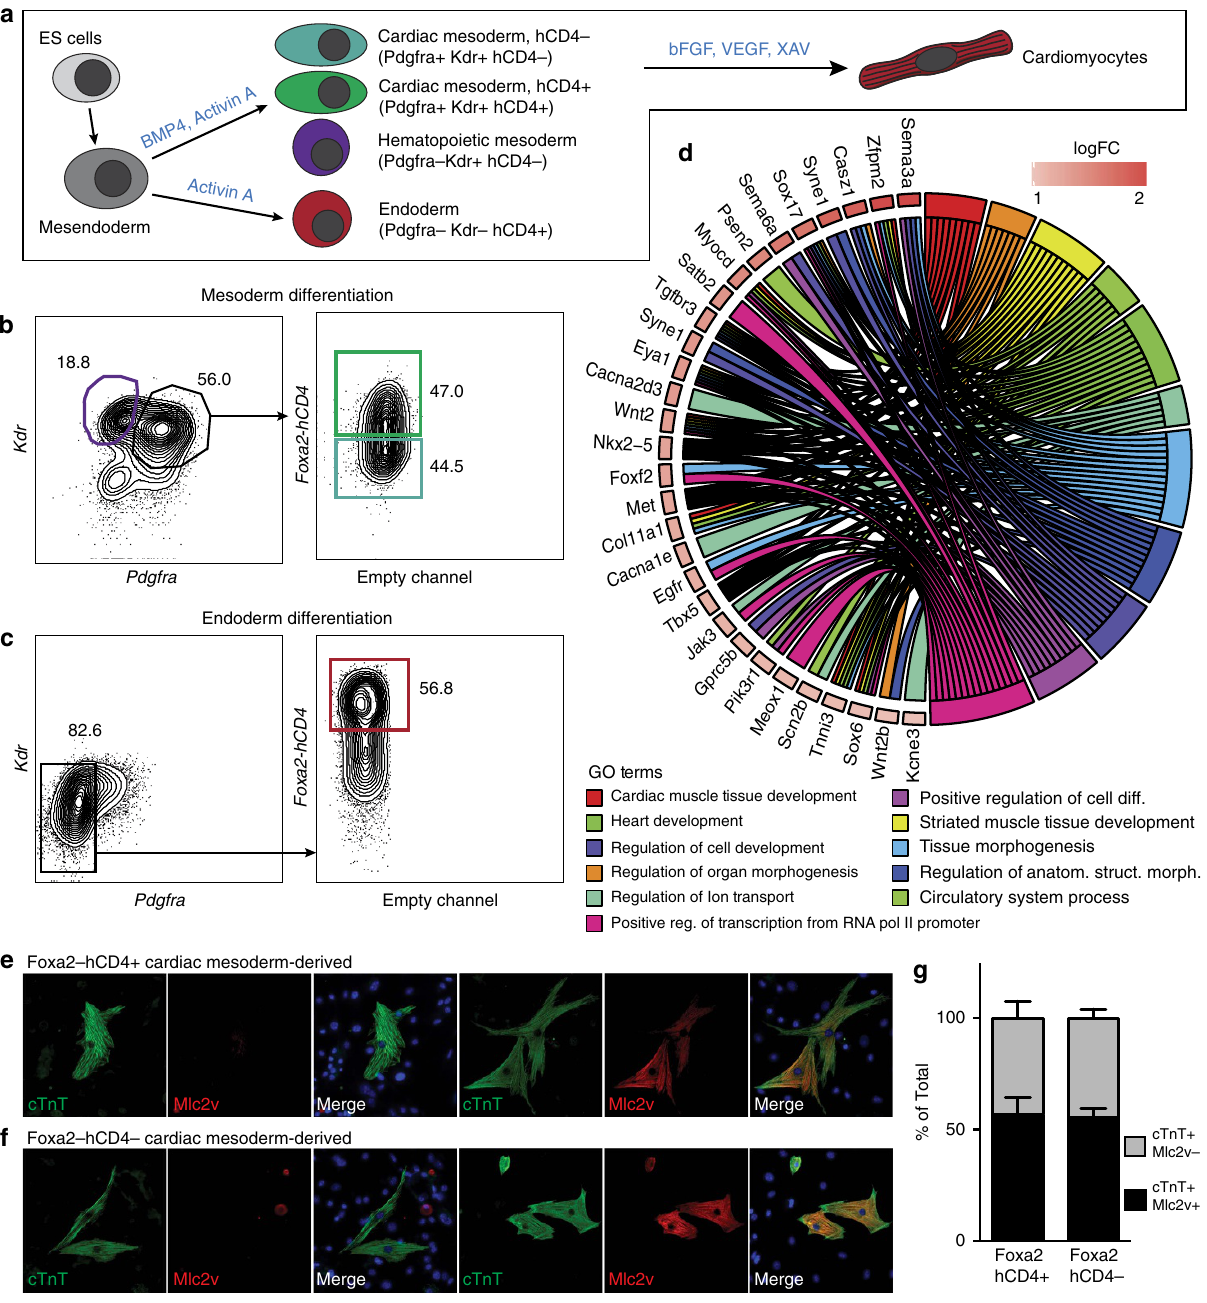
Figure 3 | Foxa2 þ CM cells can be identified and characterized during mESC differentiation. ( a ) Schematic of mESC in vitro differentiation protocols to the cardiovascular and endoderm lineages. Mesoderm cells are generated through addition of Bmp4 and Activin A, whereas endoderm cells are generated through addition of high levels of Activin A. CM is specified to the cardiomyocyte lineage through addition of basic fibroblast growth factor (bFGF), vascular endothelial growth factor (VEGF) and XAV. ( b , c ) Fluorescence-activated cell sorting (FACS) strategies for the isolation of Foxa2 þ and Foxa2 (cid:2) CM (green and teal gates, respectively), Kdr high haematopoietic mesoderm (purple gate) or Foxa2 þ endoderm (red gate) at day 5 of differentiation. ( d ) Chord plot showing a selection of genes upregulated in Foxa2 þ CM (over Foxa2 (cid:2) CM) present in the represented enriched GO terms. Outer ring shows log2 fold change (left, key at upper right) or GO term grouping (right, key below). Chords connect gene names with GO term groups. ( e , f ) IF analysis of differentiated cardiomyocytes generated from Foxa2 þ ( e ) or Foxa2 (cid:2) ( f ) CM showing expression of cTnT and Mlc2v. Images show typical cells generated in each condition. ( g ) Quantification of experiments in ( e / f ) ( n ¼ 3 differentiations, error bars reflect